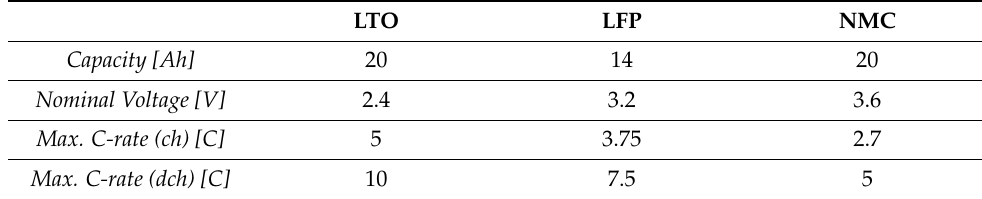
Table 5. Battery characteristics at cell